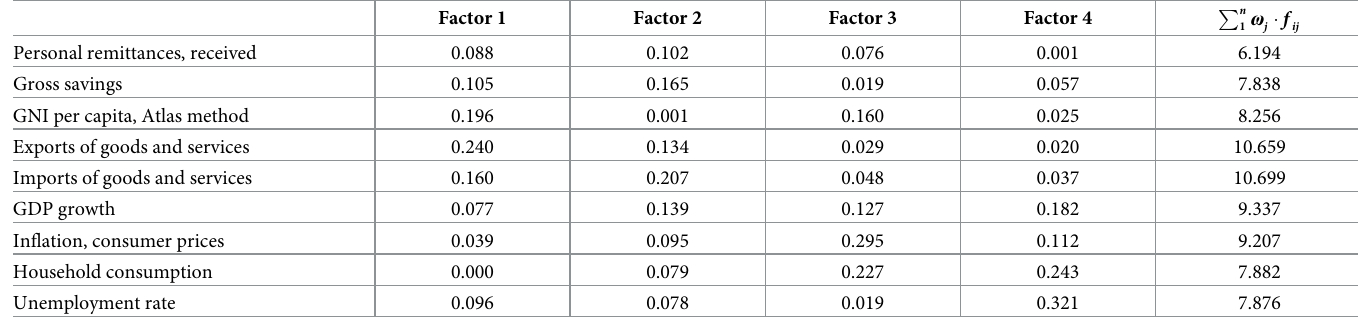
Table 5. Contribution of economic variables to each